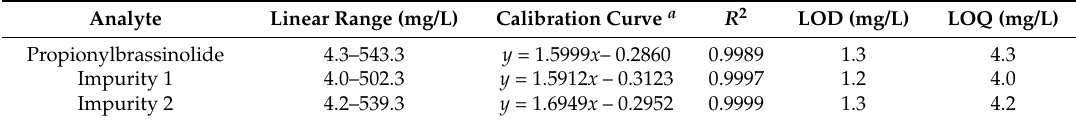
Table 1. Linearity of calibration curve of propionylbrassinolide and two impurities. Analyte